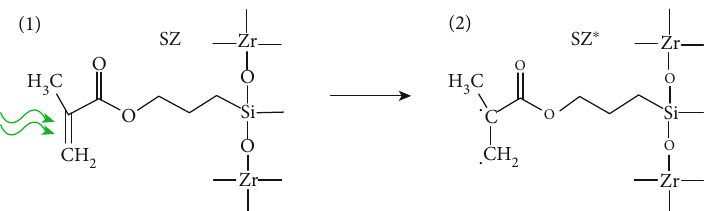
Figure 10: Proposed interaction in the acryl group in hybrid organic-inorganic photopolymer SZ2080 (SZ) during PI-free cross-linking. Direct cleavage via nonlinear absorption of a double bond in a group results in radicalization and subsequent polymerization. Adopted from [154]. Before After